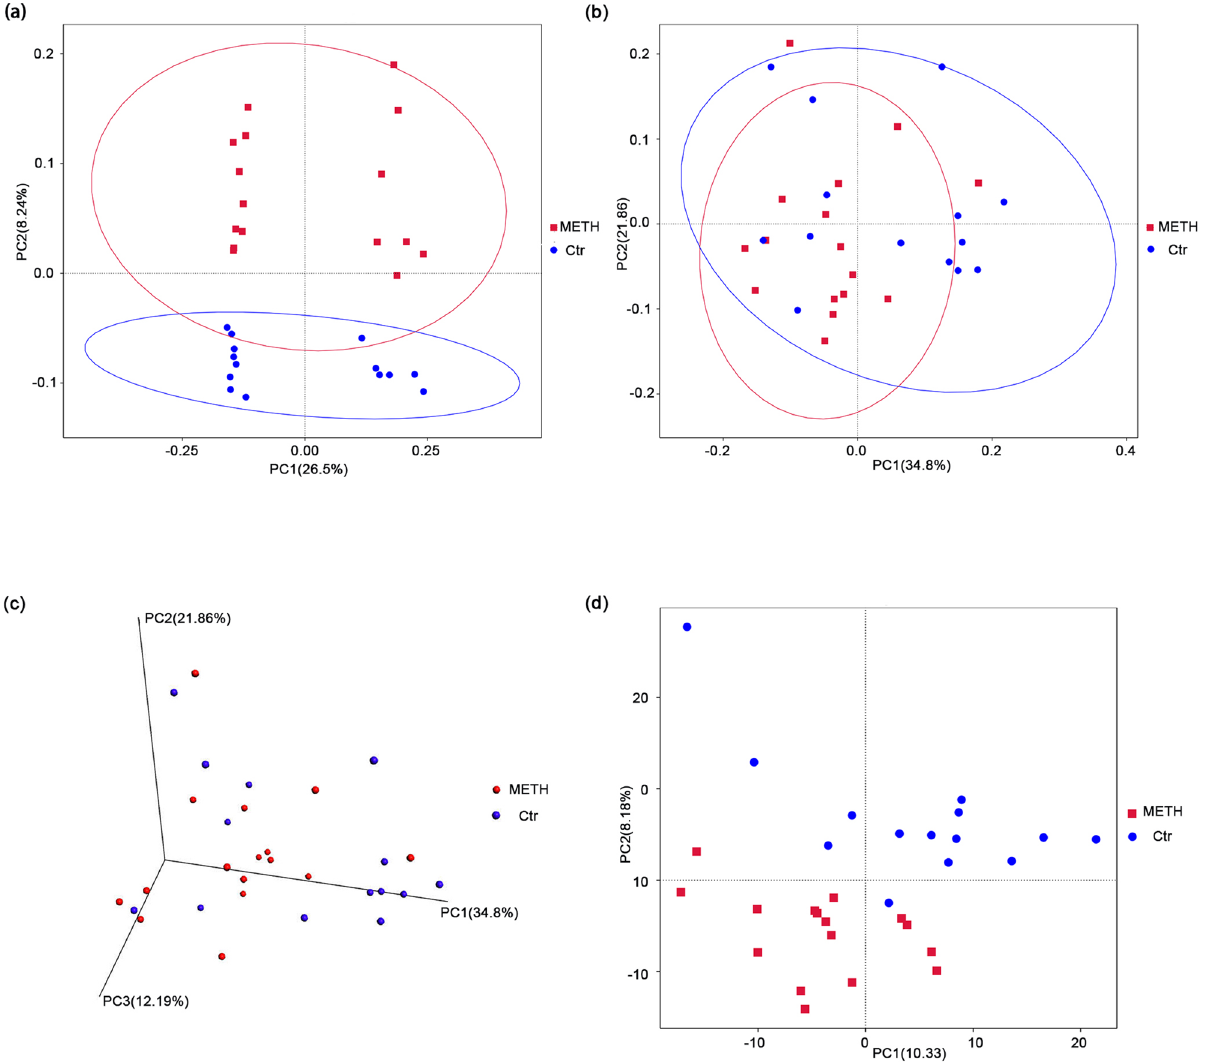
Figure 1. Subjects who abuse METH harbor an altered bacterial gut microbiota. PCoA of the bacterial beta diversity based on the ( a ) unweighted and ( b ) weighted UniFrac distances. ( c ) Three-dimensional PCoA of bacterial beta diversity based on the weighted UniFrac distances. ( d ) PCA of bacterial beta diversity based on the Euclidean distances. Subjects who abuse METH and Ctr subjects are colored in red and blue,